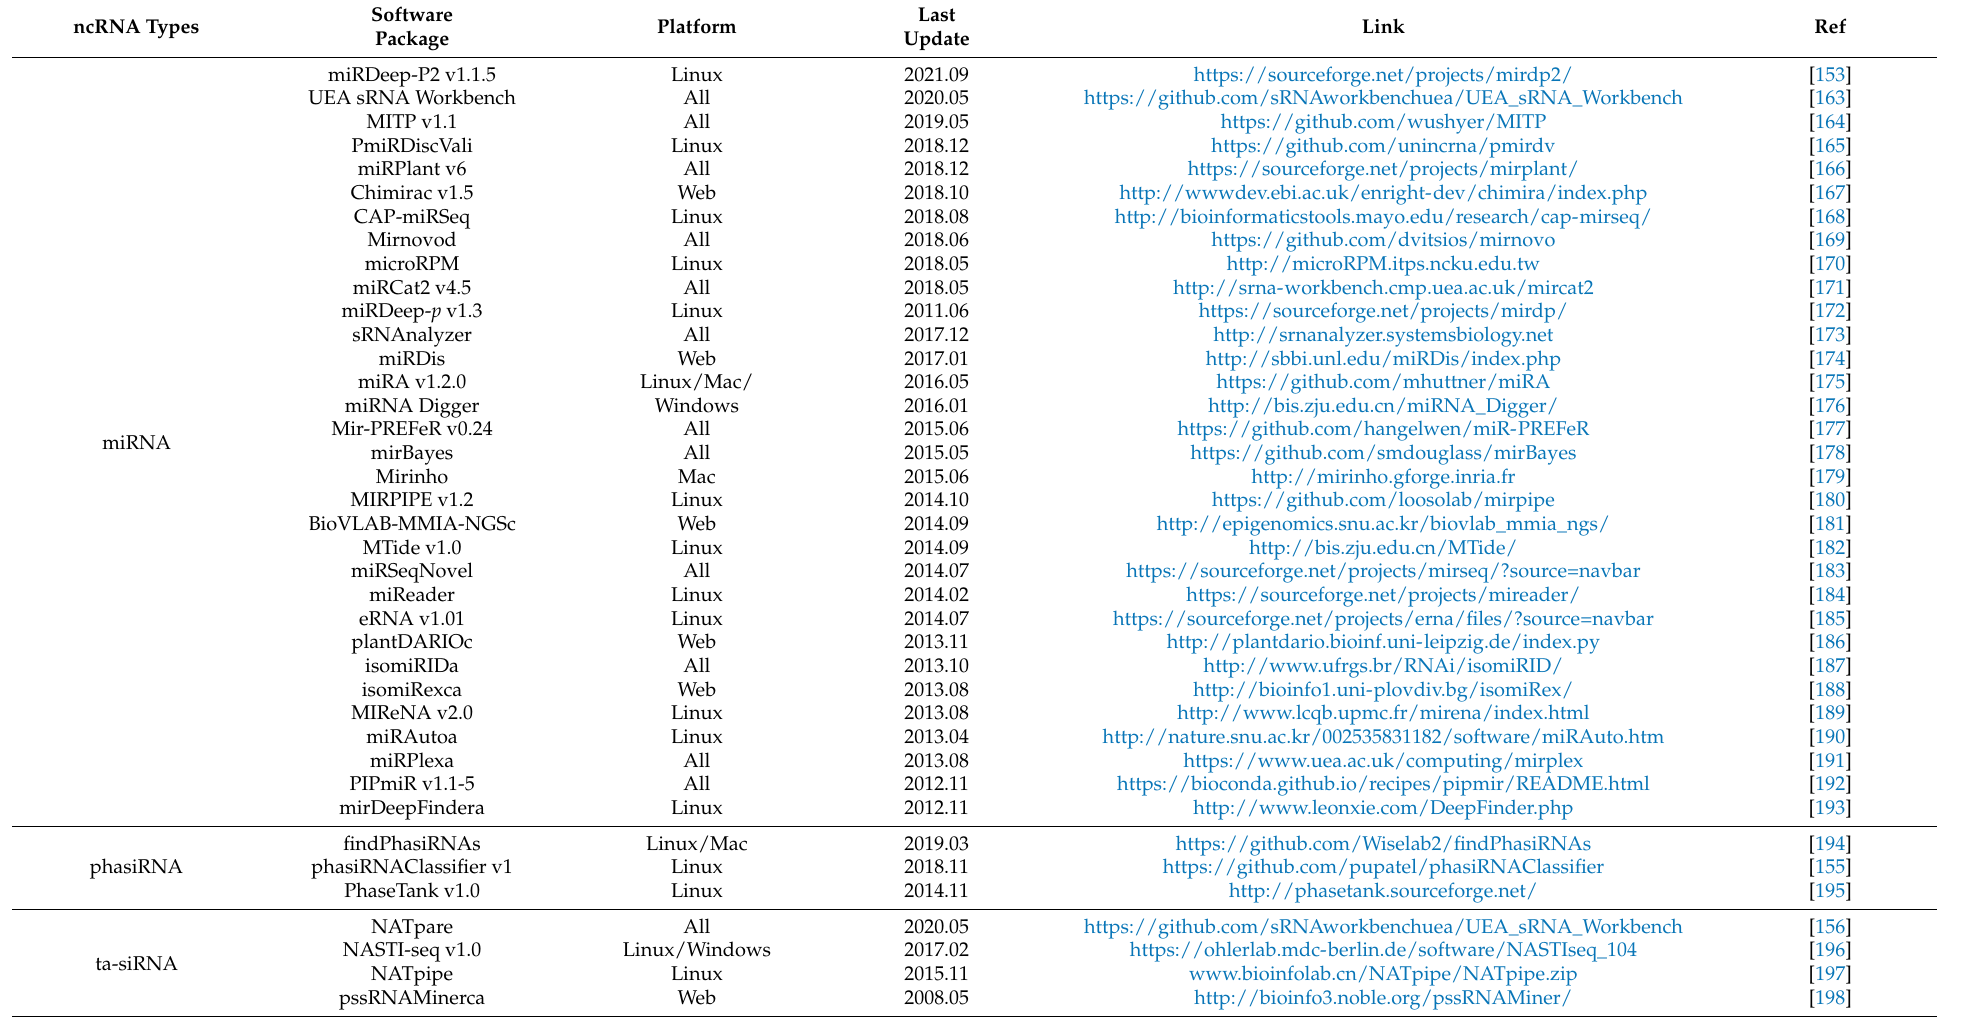
Table 1. List of ncRNA prediction tools in